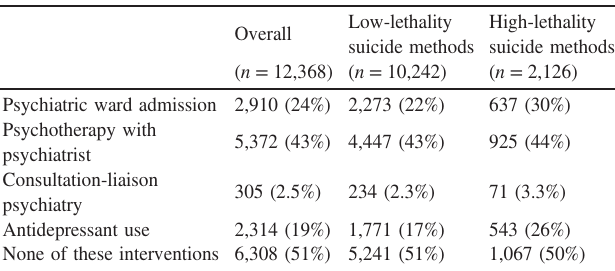
Table 3. Psychiatric interventions during hospitalization among patients discharged to home